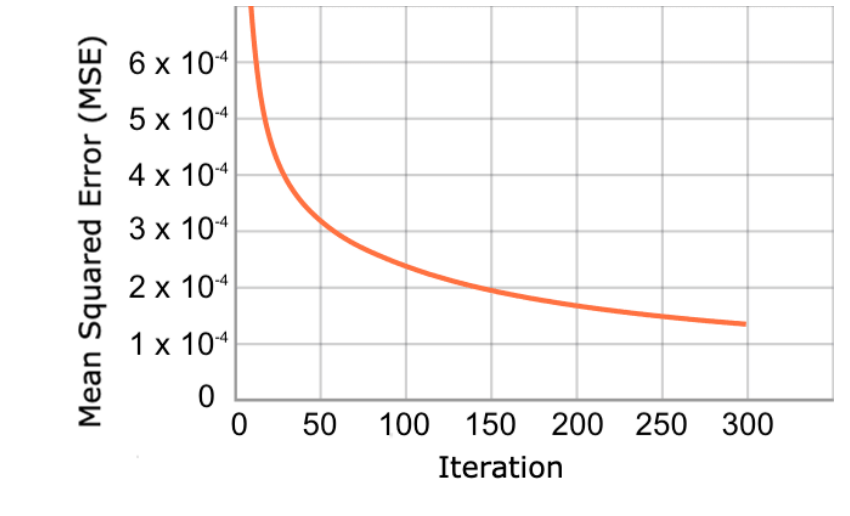
Figure 5. Evolution of training cost function. The function decreases by minimizing the reconstruction error of the trajectories in the training set.